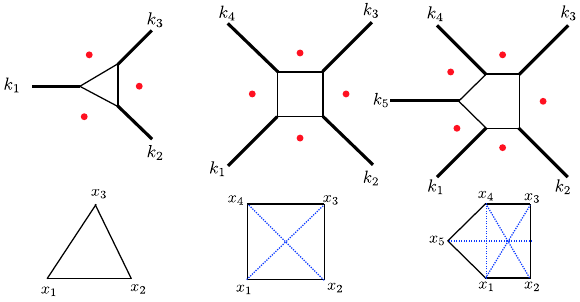
Figure 7. Naive correspondence between multipoint energy correlators and dual coordinates for Feynman graphs. This correspondence is broken by eikonal terms in the splitting functions that introduce eikonal propagators into the dual Feynman